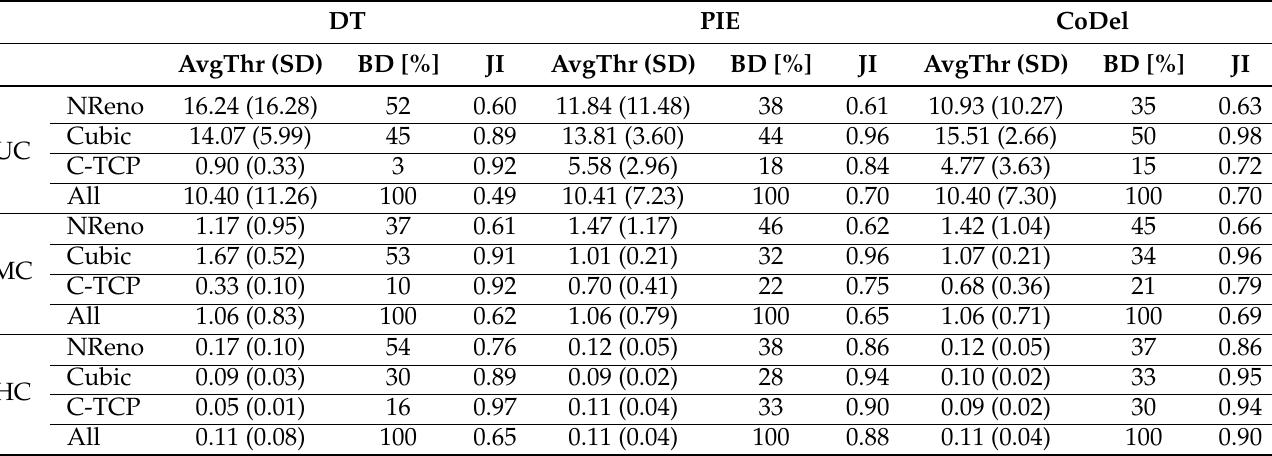
Table 12. The summary results in the Access Link scenario with mixed TCPs, UC—uncongested, MC—mildly congested, HC—eavily congested network.